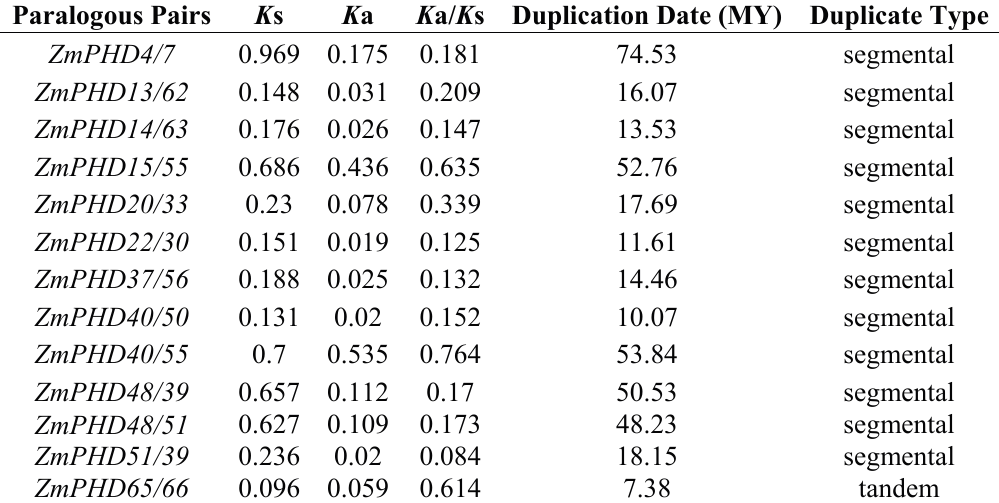
Table 2. K a/ K s analysis and divergence time estimated for maize duplicated PHD